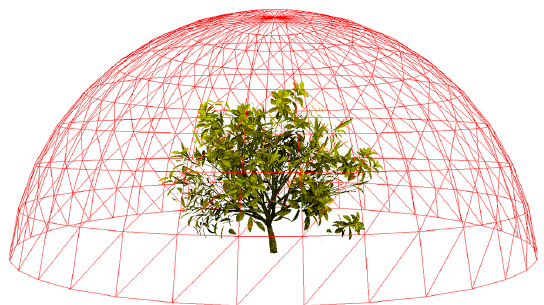
Figure 5. Schematic representation of the diffuse sky light source with a discretized hemisphere over the canopy that consists of a number of triangular facets. The light source consists of rays traveling from the light plane to the canopy.